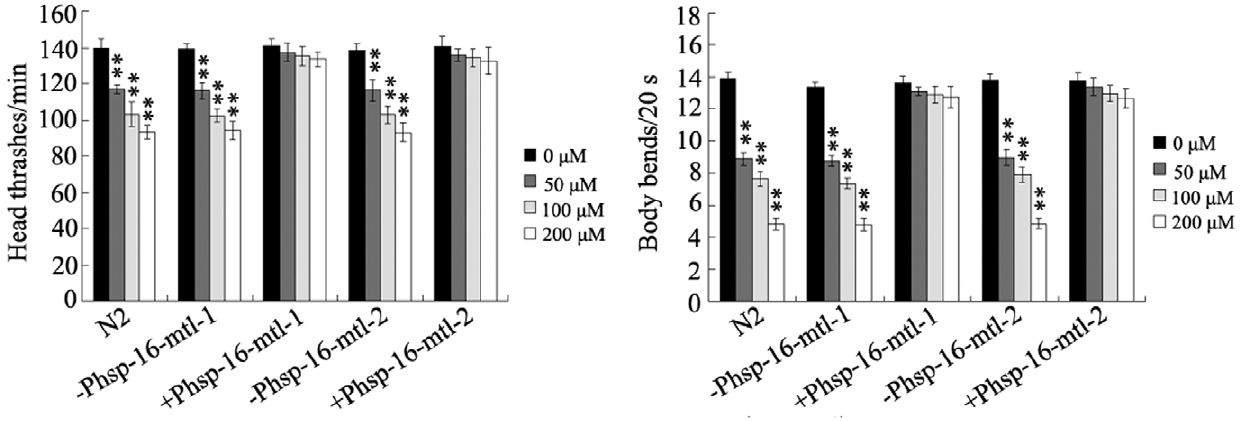
Figure 9. Effects of MTL-1 and MTL-2 over-expression at the L2-larval stage on the neurobehavioral toxicity induced by Pb exposure. –P hsp-16-mtl-1 and –P hsp-16-mtl-2 , wild-type animals carrying P hsp-16-mtl-1 or –P hsp-16-mtl-2 without heat-shock treatment; –P hsp-16- mtl-1 and –P hsp-16-mtl-2 , wild-type animals carrying P hsp-16-mtl-1 or –P hsp-16-mtl-2 treated with heat-shock (30 u C, 4-hr) at the L2-larval stage. Bars represent means 6 S.D. ** p , 0.01 vs 0 m M.